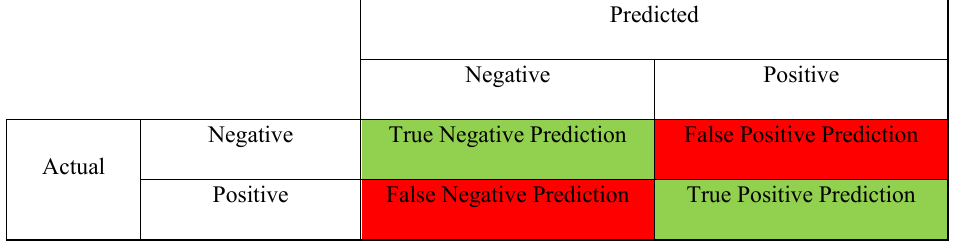
Fig. 6. General Representation of the Confusion Matrix (For Binary Classification)